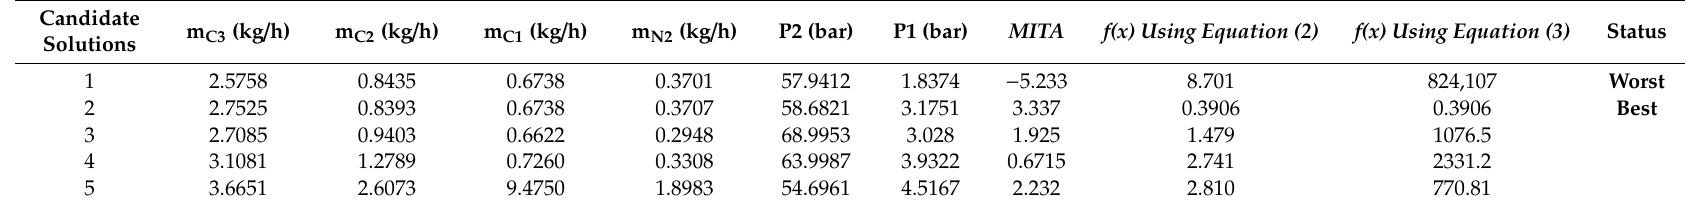
Table 9. New values of decision variables and the corresponding energy for the SMR process during the second iteration.